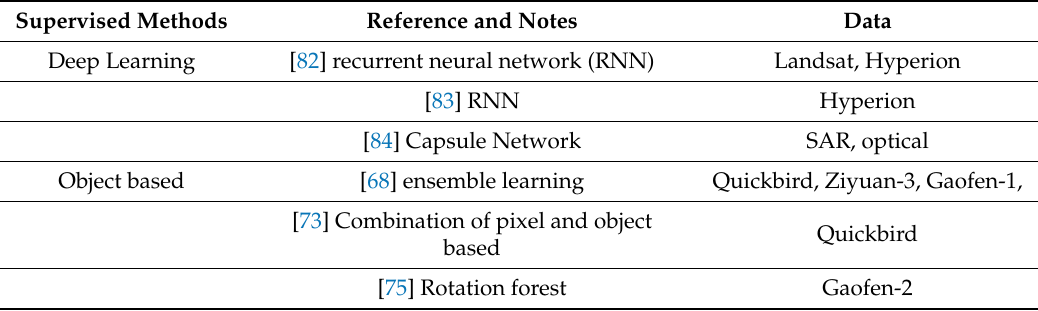
Table 1. Summary of recent supervised change detection